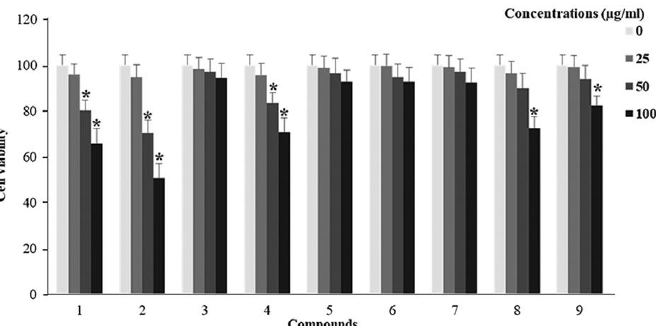
Figure 3. Evaluation of the effect of compounds ( 1 – 9 ) on cell viability of ARPE-19 cells. Cells were treated with compounds ( 1 – 9 ) at 25, 50 and 100 µg/mL for 24 h. A 0.5% DMSO was used as a control group. After incubation, cell viability was determined using an MTT assay. Results present average cell viability as mean ± SD ( n = 4). The symbol * indicates significantly different from the control group ( p < 0.05).